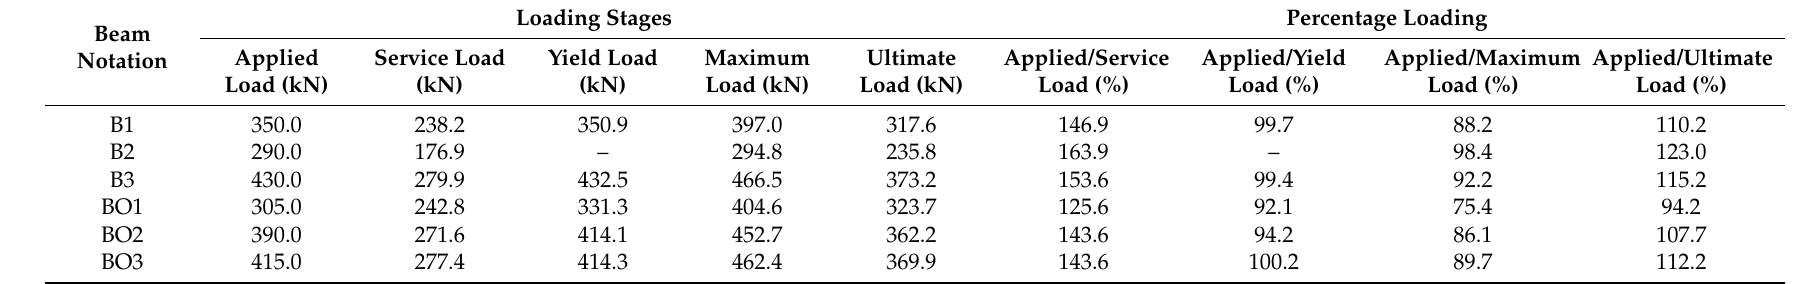
Table 6. Applied load to service, yield, maximum and ultimate load